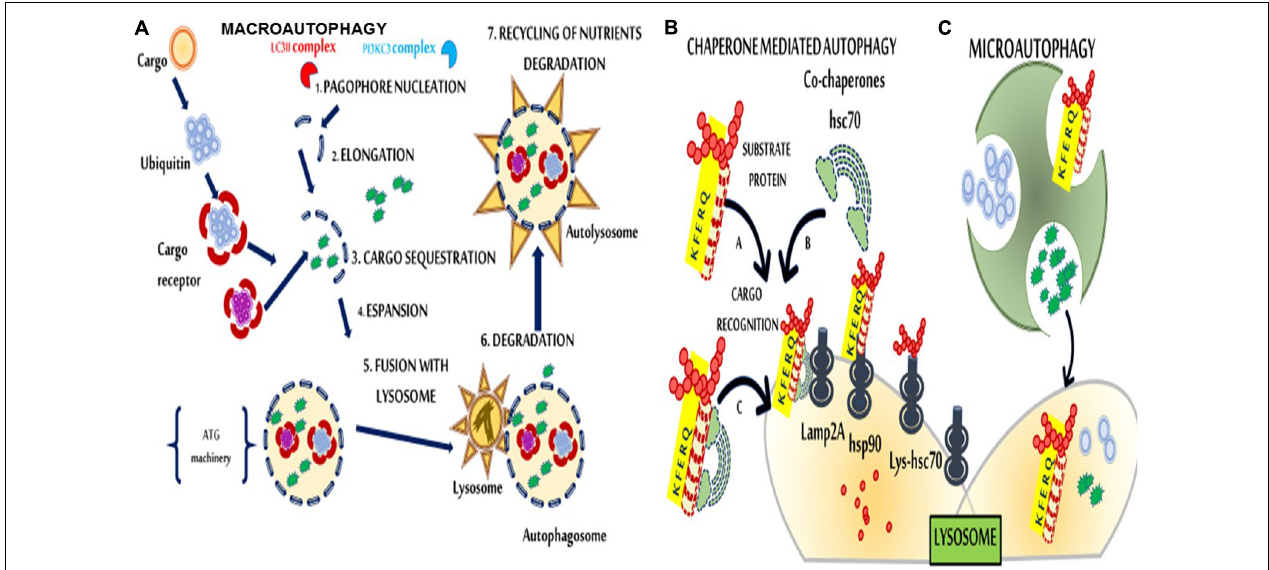
FIGURE 1 | Schematic representation of macroautophagy, chaperone-mediated autophagy (CMA), and microautophagy. (A) In macroautophagy, cargos are sequestered by phagophores, which elongate and form a double membranous structure, the autophagosome. Autophagosomes then fuse with the lysosome to form autolysosomes. (1) Nucleation consists of the formation of the phagophore. A class III of phosphoinositide 3-kinases (PI3K) complex consisting of beclin 1 (BCN1), Phosphatidylinositol 3-kinase catalytic subunit type 3 (PIK3C3), Phosphoinositide 3-kinase regulatory subunit 4 (PIK3R4), UV radiation resistance-associated gene protein (UVRAG), and Autophagy And Beclin 1 Regulator 1 (AMBRA1) is required for phagophore formation. (2) Microtubule-associated proteins 1A/1B light chain 3B (MAP1LC3) complex anchors to the membrane via a phosphoethanolamine (PE) anchor (LC3-II) and triggers the elongation. (3) The phagophore sequesters cytosolic cargo and forms a double-membranous vesicle, the autophagosome. (4) Maturation, the completed autophagosome undergoes multiple maturation steps. (5) Docking and fusion, the autophagosome is released into the lysosome/autolysosome to be degraded by lysosomal hydrolases or to become available for re-usage (6). (B) In CMA (left) , substrate proteins that can be damaged by various factors, such as reactive oxygen species (ROS), bind the Lysosomial- Heat shock cognate 71 kDa protein (Lys-Hsc70) chaperone through a specific amino acid sequence (the KFERQ motif) and are transported across the lysosomal membrane for degradation via interaction with lysosomal-associated membrane protein 2A (Lamp2A) proteins. (C) Microautophagy (right) involves the direct engulfment of portions of the cytoplasm into lysosomes.